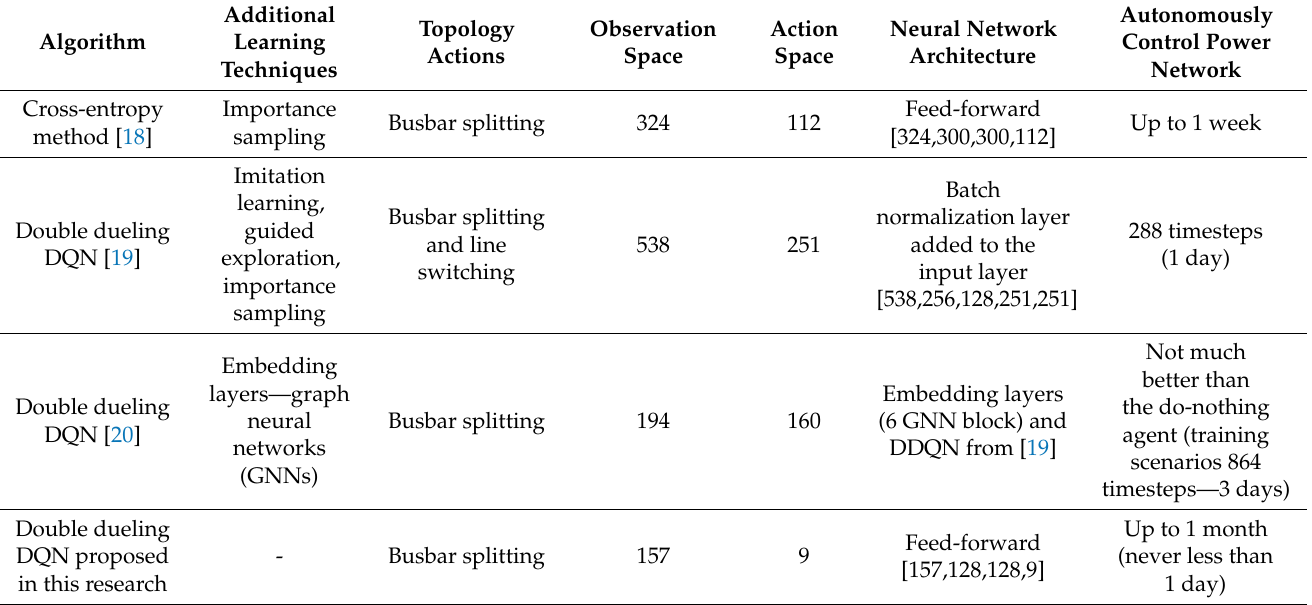
Table 6. Overview of presented approaches from literature and comparison with RL agent proposed in this